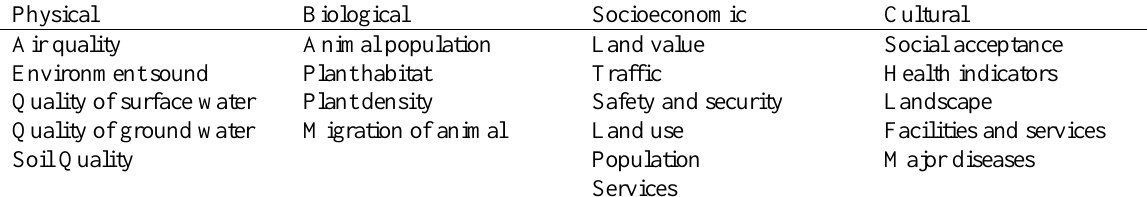
Table 4. Environmental components in Iranian Leopold